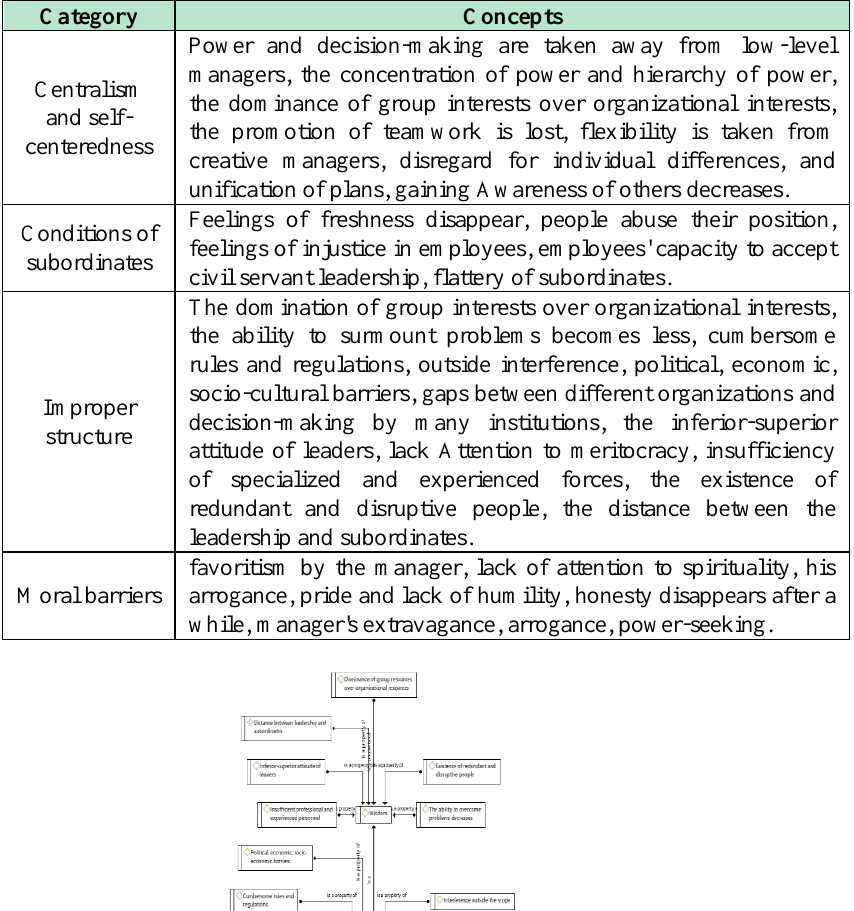
Table 2: Open coding of barriers affecting the implementation of servant leadership